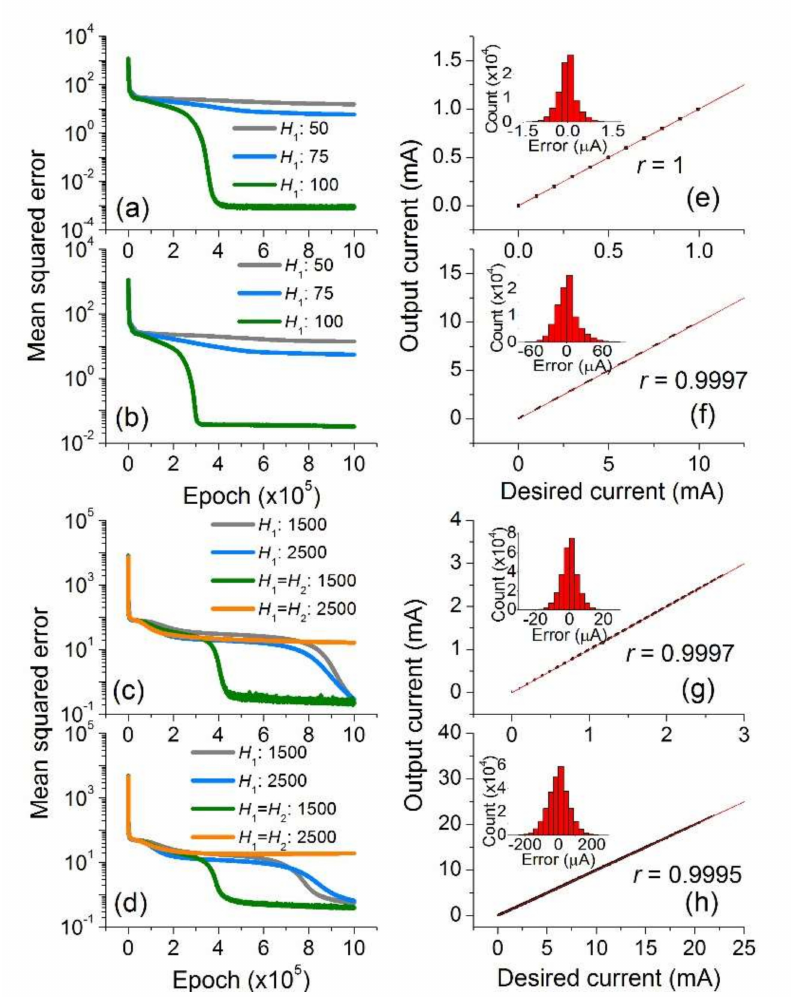
Figure 2. Inference-error reduction while training a network with the dataset of a 10 × 9 crossbar array of ( a ) Type A and ( b ) Type B switches. Their output results (inferred currents) for the entire 10,000 test datasets after successful training (green lines) are plotted against the desired currents in ( e ) and ( f ), respectively. The histogram of the error (the difference between inferred and desired currents) for each case is shown in the inset. The red solid lines denote the perfect match of inference with the desired (correct) results. The results are shown for a 28 × 27 crossbar array of ( c ) Type A and ( d ) Type B switches, and their statistics in ( g ) and ( h ),